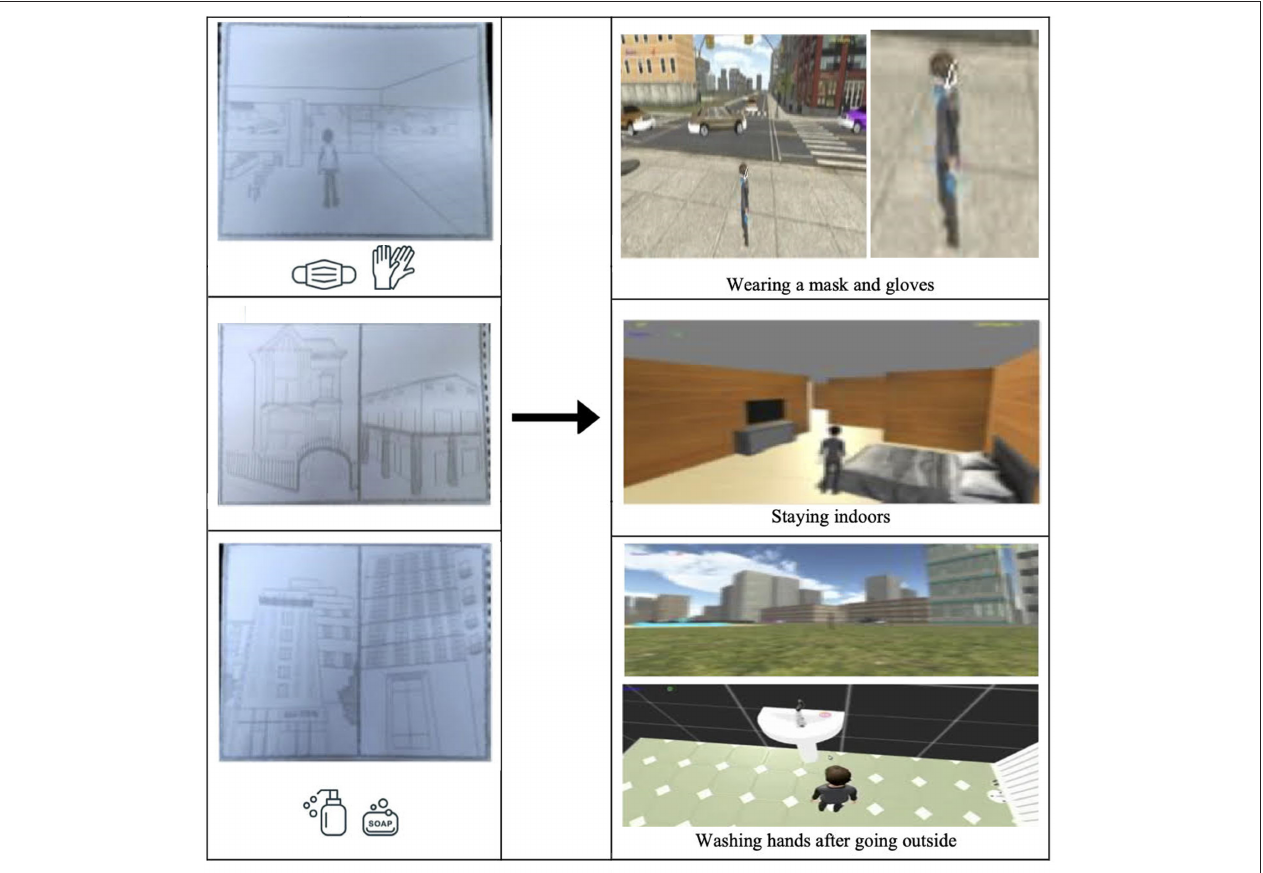
FIGURE 1 | From hand modelling to graphical user interface (GUI) design of a potential application or module for teaching Covid-19 measures to children with autism, adapted from ( 3).